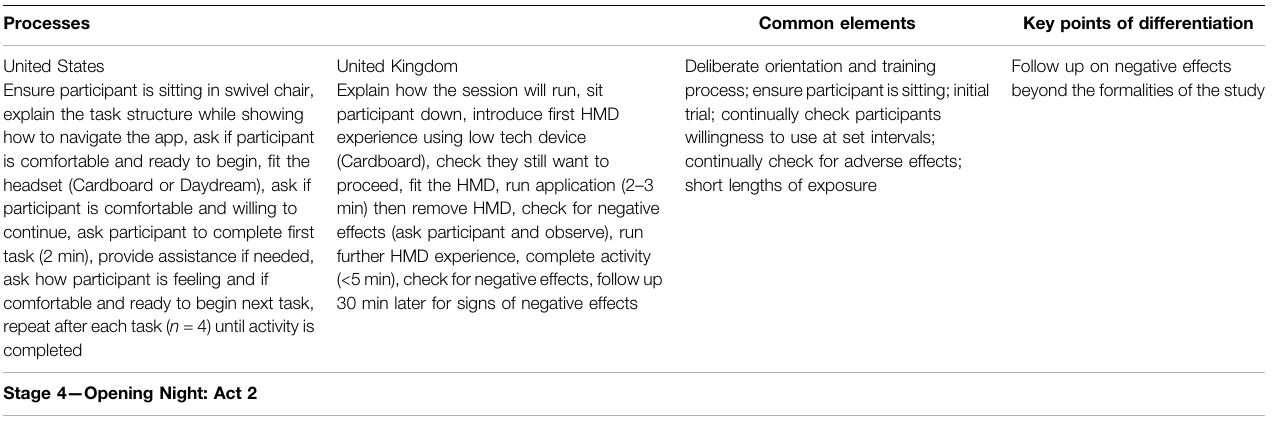
TABLE 7 | Results from thematic analysis: Stage 4 Opening Night (Acts 1 and 2). Stage 4 — Opening Night: Act